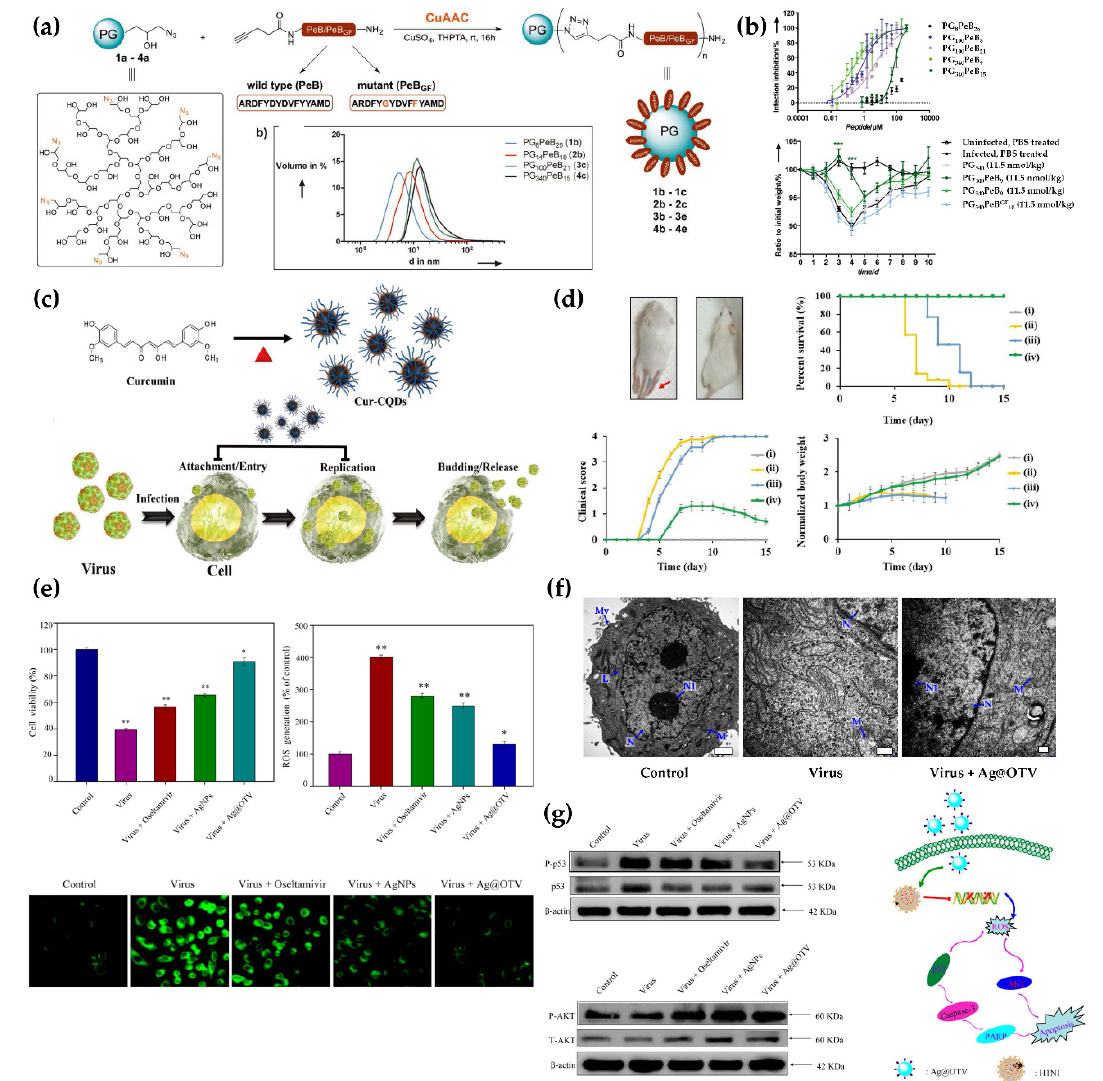
Figure 6. ( a ) Scheme for polymeric nanoparticle (PGs) conjugated with peptide (PeB) in various molecular weights is represented. ( b ) Inhibition of influenza A virus infection by PG-PeBs, prepared using different molecular weights of PeBs, was evaluated in vitro (top) and in vivo (bottom) (*** p < 0.001). Reproduced with permission from [175]. Copyright (2017) Wiley. ( c ) Schematics showing the synthetic process of curcumin-derived copper QDs (Cur-CQDs) (top) and their mechanism of antiviral activity (bottom). ( d ) Therapeutic effect of Cur-CQDs against enterovirus 71 (EV71) infection was evaluated in an in vivo study. Survival rates, clinical scores, and body weights of (i) mice without infection and mice injected with (ii) PBS, (iii) curcumin, or (iv) Cur-CQDs, followed by challenge with EV71. Reproduced with permission from [179]. Copyright (2019) Wiley. ( e ) Antiviral activity of silver nanoparticles decorated with antiviral agents (Ag@OTV) was evaluated by determining the viability of H1N1-infected cells (top) and analyzing the ROS production detected based on DCF fluorescence intensity (bottom) in H1N1-infected cells. One-way analysis of variance (ANOVA) was used for statistical analysis. Data represent mean ± standard deviation (* p < 0.05 or ** p < 0.01) ( f ) TEM image cell sections treated with control media (left), virus (middle), and virus + Ag@OTV (right), where the scale bars were 1 µ m (left), 200 nm (middle), and 200 nm respectively. ( g ) ROS-mediated apoptotic signaling pathway, as well as p53 and AKT signaling pathways, are regulated by Ag@OTV. Reproduced with permission from [181]. Copyright (2016) American Chemical